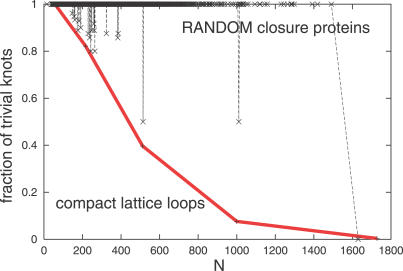
Fraction of Protein Chains at a Given Length with a Trivial Knot (01) in the RANDOM Method, Plotted against the Length or Number of ResiduesAdjacent points are connected by dashed lines. The data for the trivial knotting probability of compact lattice loops (from 4 × 4 × 4 to 12 × 12 × 12) is included, shown connected by thick lines.